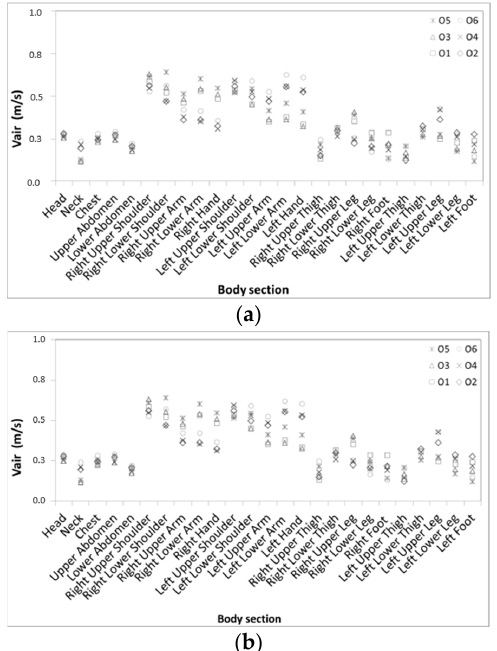
Figure 14. Mean air velocity value around the 25 human body sections of 6 occupants, for an inlet air temperature of ( a ) 20 °C and ( b ) 24 °C.